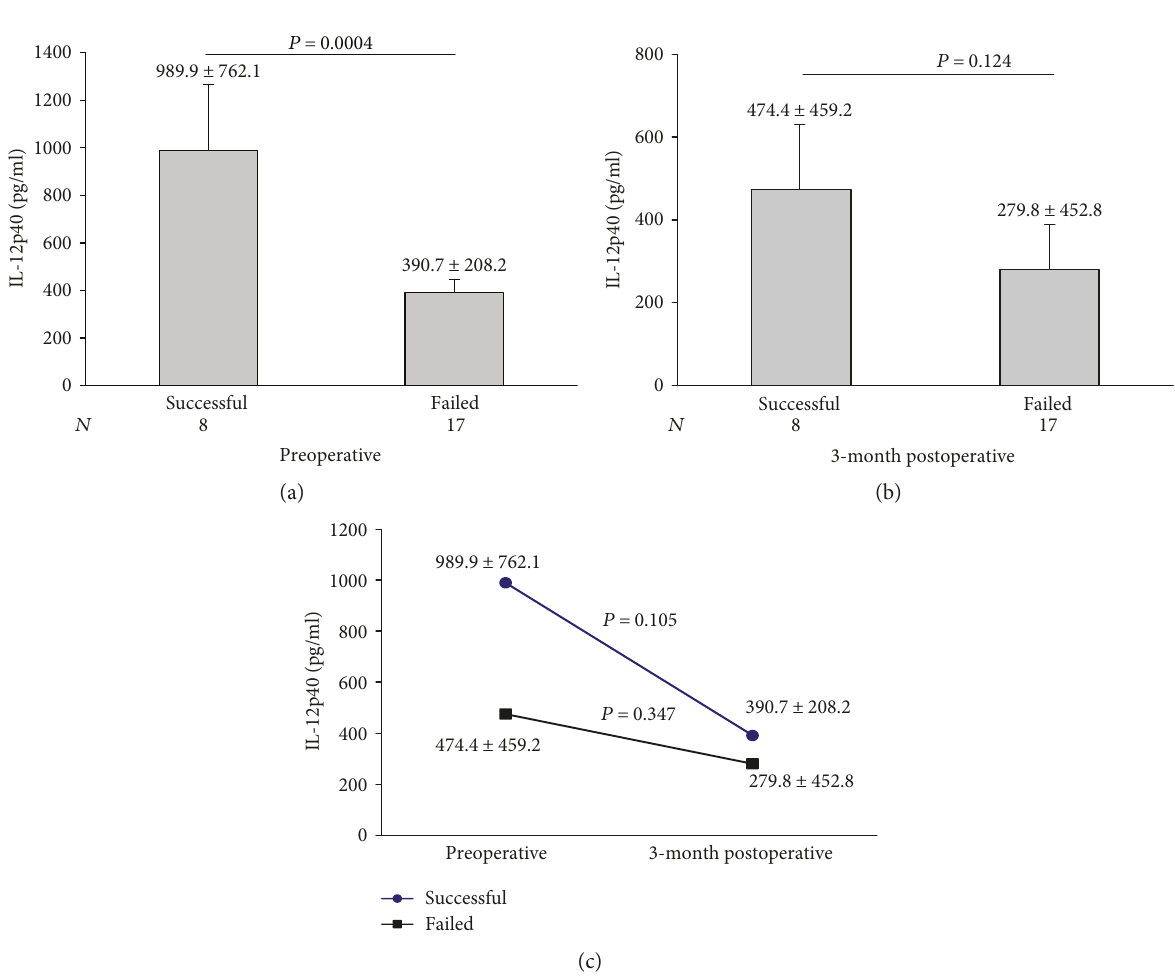
Figure 2: Comparison of serum IL-12p40 between BA patients with successful and those with failed Kasai operation. (a) Preoperative and (b) 3-month postoperative (c) paired analysis of preoperative and the 3-month postoperative IL-12p40 levels in patients with successful Kasai (upper slope) and those with failed Kasai (lower